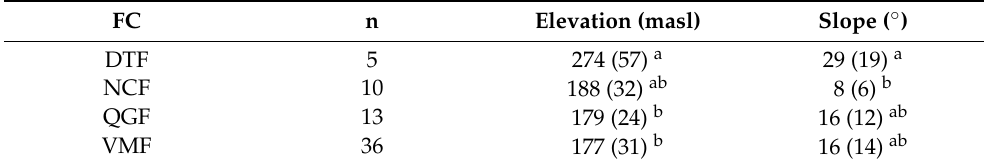
Table 2. Topographic factors in the identified forest community types in Htamanthi Wildlife Sanctuary in Myanmar. Values in parenthesis are the standard deviations from the mean. Different lowercase letters indicate statistical significance between community types at α = 0.05. FC n Elevation (masl) Slope ( ◦ ) DTF